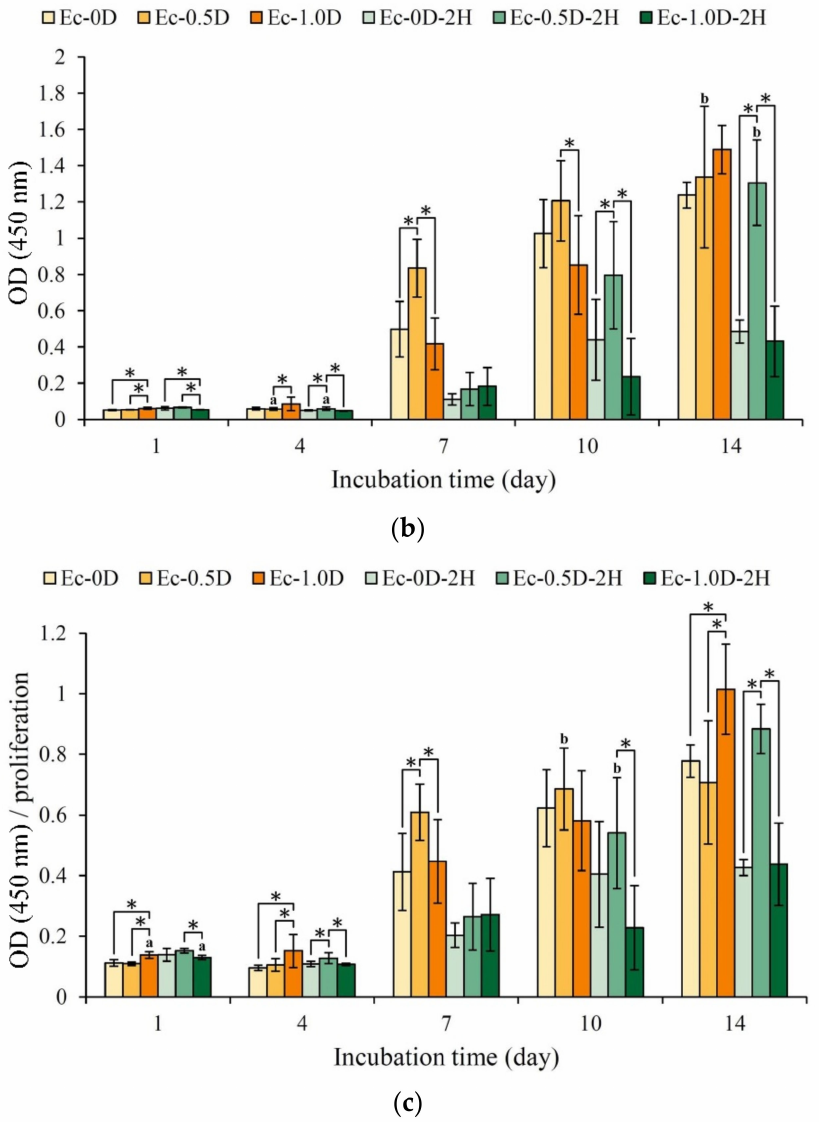
Figure 11. Cell proliferation of hydrogel membranes in contact with D1 cells for 1, 4, 7, 10, and 14 days ( a ). optical density OD 450 of total cell ALP activity ( b ) and OD 450 /proliferation indicates ALP semi-quantitation ( c ) (the symbol * indicates that each group shows p < 0.05, and the same alphabet indicates that the experimental group after t -test shows p >